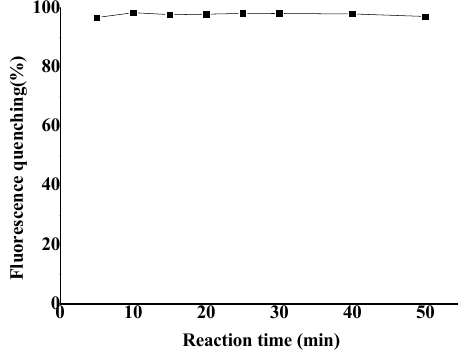
Figure 7. The influence of reaction time on the fluorescence quenching Alcian 8GX on AlS 4 Pc. The concentration of AlS 4 Pc, Alcian blue 8GX, and Hg(II) were 1.0 × 10 − 6 mol/L, 1.50 × 10 − 6 mol/L, and 1.0 × 10 − 5 mol/L, respectively.